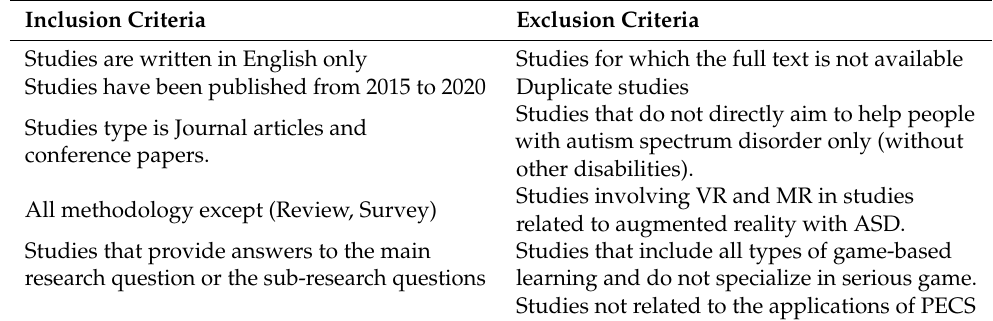
Table 6. Criteria for inclusion and exclusion of the articles.